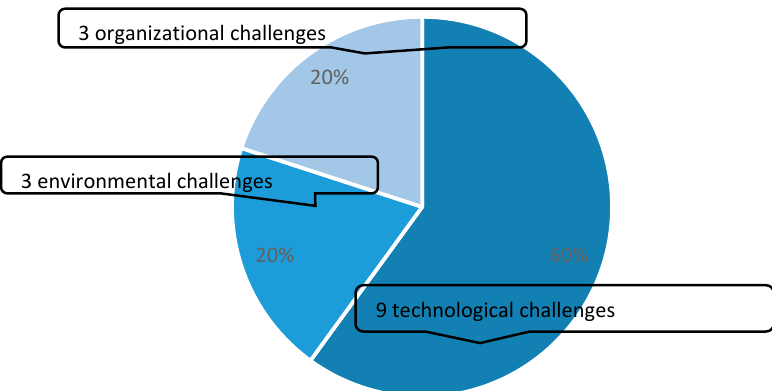
Figure 2. The number of challenges identified in each context of the TOE framework.